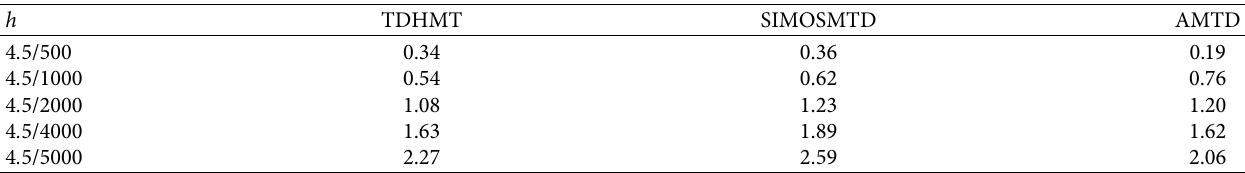
Table 5: Comparison of the CPU time of TDHMT with the CPU time of other existing methods, namely, SIMOSMTD and WETMTD for Example 3.